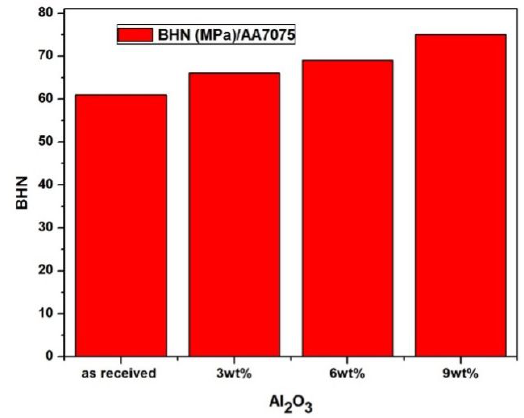
Figure 6: The variation of BHN with Al 2 O 3 wt% in comparison with the experimental